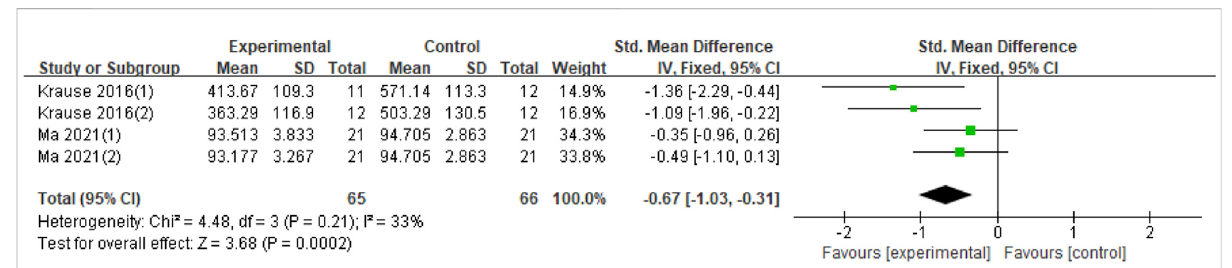
FIGURE 7 Forest plot for the effect of tACS on improving motor learning. Notes: Krause (1) (2)- The 10 Hz and 20 Hz stimuli in this study, respectively; Ma (1) (2)- The 20 Hz and 70 Hz stimuli in this study, respectively.